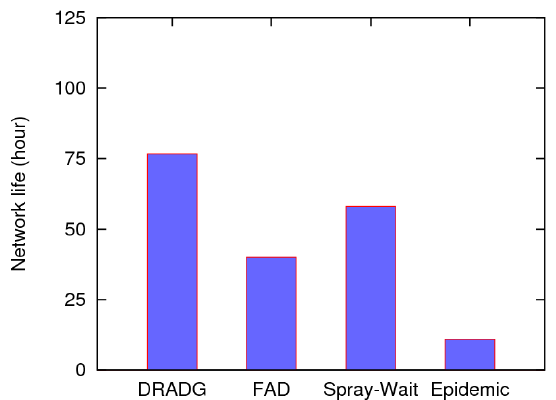
Figure 7. The network life under scenario